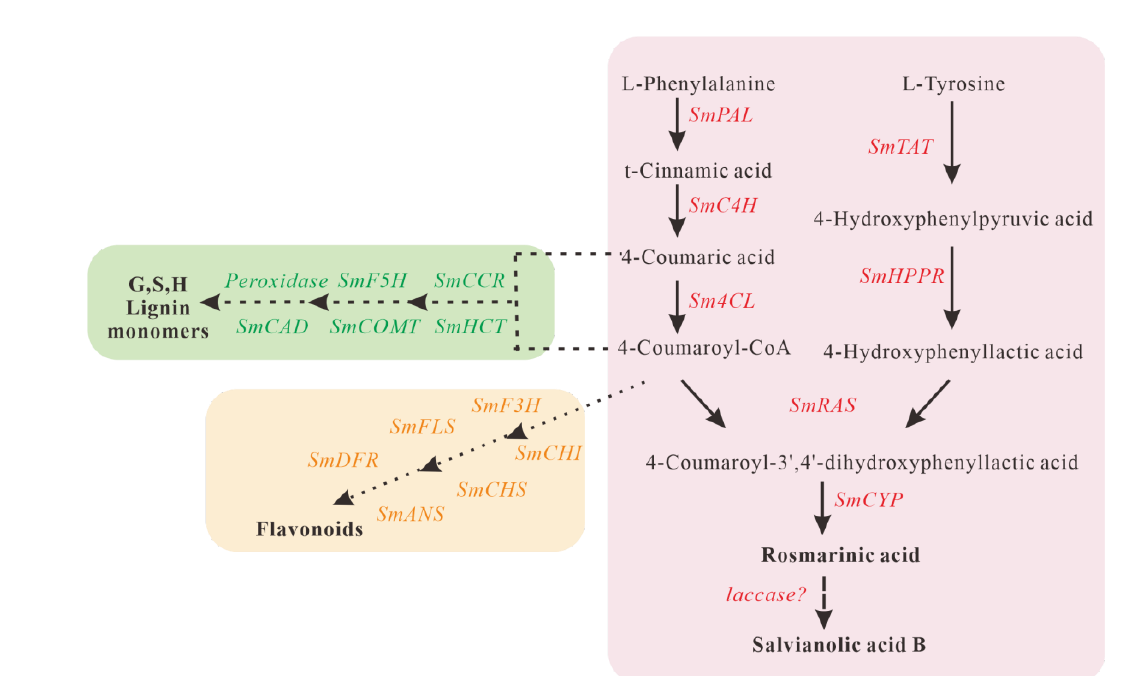
Figure 1. The proposed biosynthetic pathways for phenolic acids, flavonoids, and lignin in Salvia miltiorrhiza . PAL , phenylalanine ammonia lyase; C4H , cinnamate 4-hydroxylase; 4CL , hydroxycinnamate-CoA ligase; TAT , tyrosine aminotransferase; HPPR , hydroxyl phenylpyruvate reductase; RAS , rosmarinic acid synthase; CYP , cytochrome P450 enzymes; CHI , chalcone isomerase; F3H , flavanone 3-hydroxylase; CHS , chalcone synthase; FLS , flavonol synthase; DFR , dihydroflavonol 4-reductase; ANS , anthocyanin synthase; HCT , hydroxyl cinnamoyl transferase; CCR , cinnamoyl-CoA reductase; COMT , caffeic acid O-methyltransferase; F5H , ferulate 5-hydroxylase; CAD , cinnamyl alcohol dehydrogenase. Solid lines indicate the step is specific. Dashed lines indicate the step is uncertain or multiple enzymatic steps are represented.